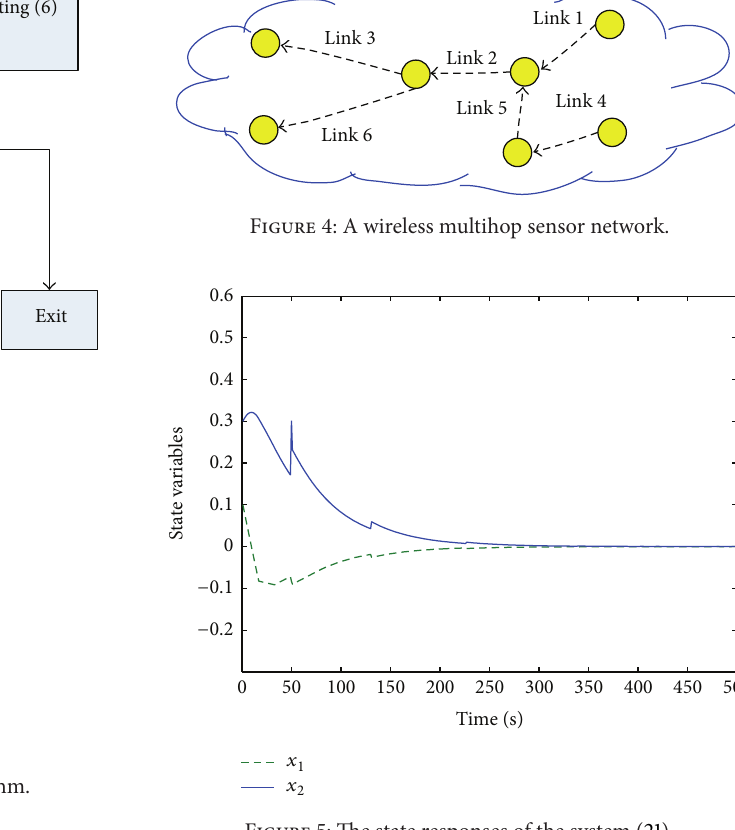
Figure 5: The state responses of the system